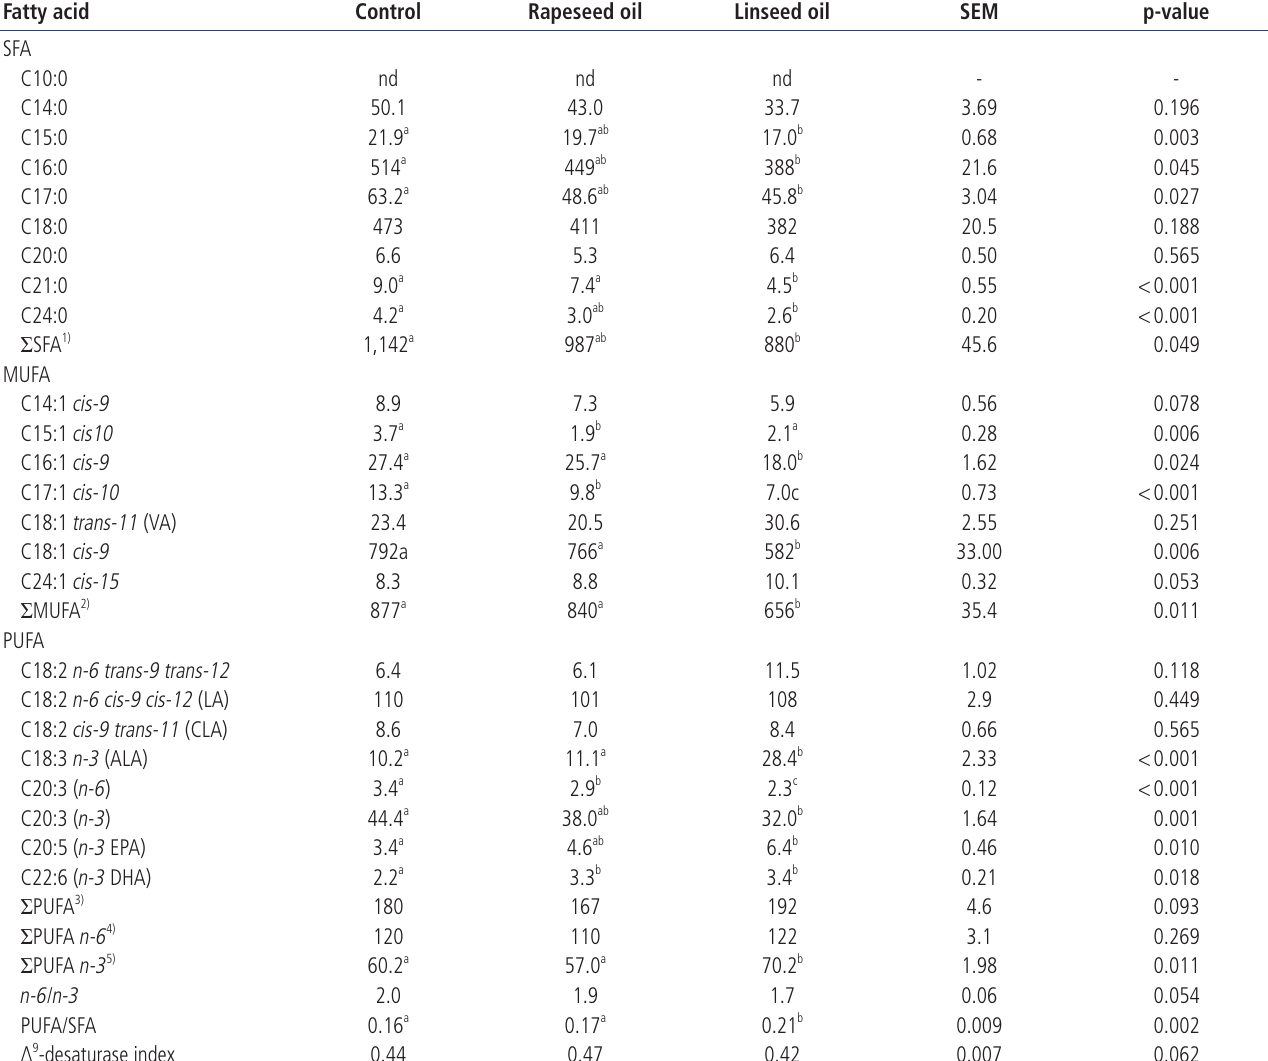
Table 5. The fatty acid composition of longissimus dorsi muscle in lambs (mg FAME/100 g